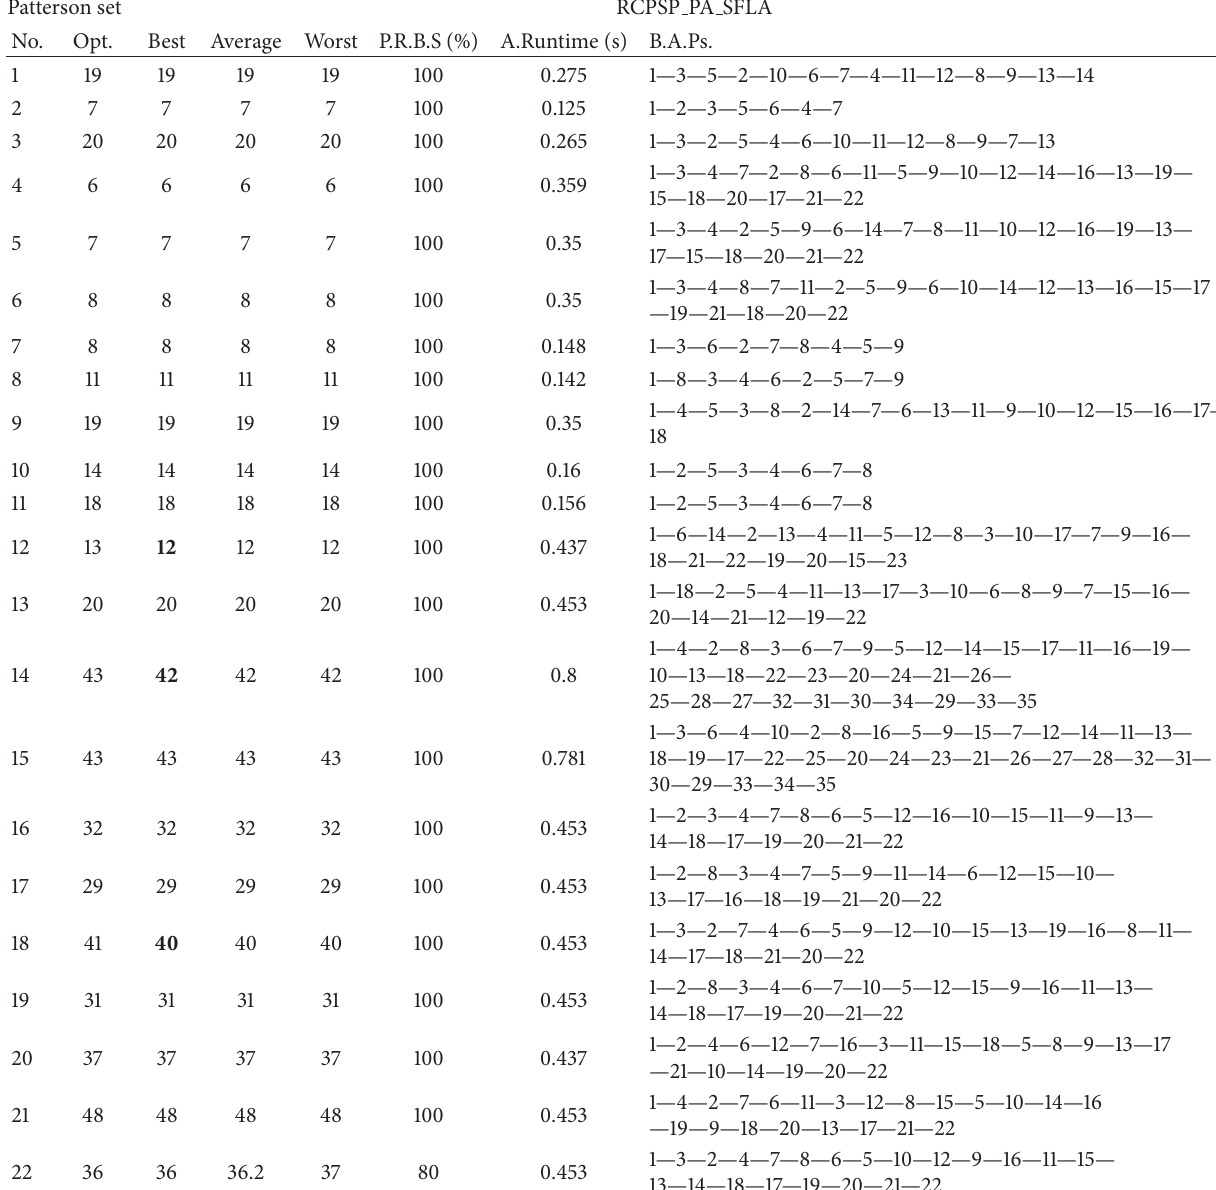
Table 1: Computational results of RCPSP PA SFLA for Patterson set